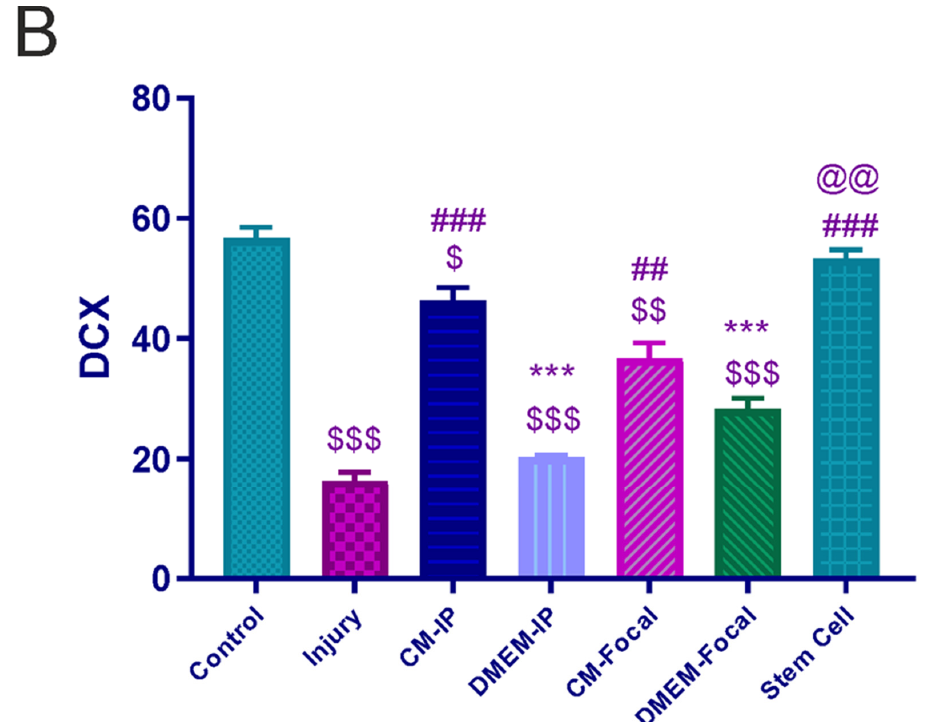
Figure 3. Immunofluorescence staining two weeks’ post-injury for DCX + . ( A ) The double staining of DCX for the effect of hAFMSC-CM on DCX in spinal cord injury by confocal microscopy. DCX -positive neuroblasts (green, 2 weeks’ post-injury) were detected in the spinal cord. Nuclei were counterstained with DAPI(blue). After SCI treatment with CM in the form of IP and Focal, stem cells showed an increase in DCX ( p < 0.001). Data represent means ± SEM. Scale bars = 20 µ m. ( B ), the quantification of immunostaining data showed an increase in DCX + cells in different groups. $$$ p < 0.001, $$ p < 0.01, $ p < 0.05 versus control. ### p < 0.001, ## p < 0.01, versus injury. *** p < 0.001, versus CM-IP. @@ p < 0.01, versus CM- Focal.